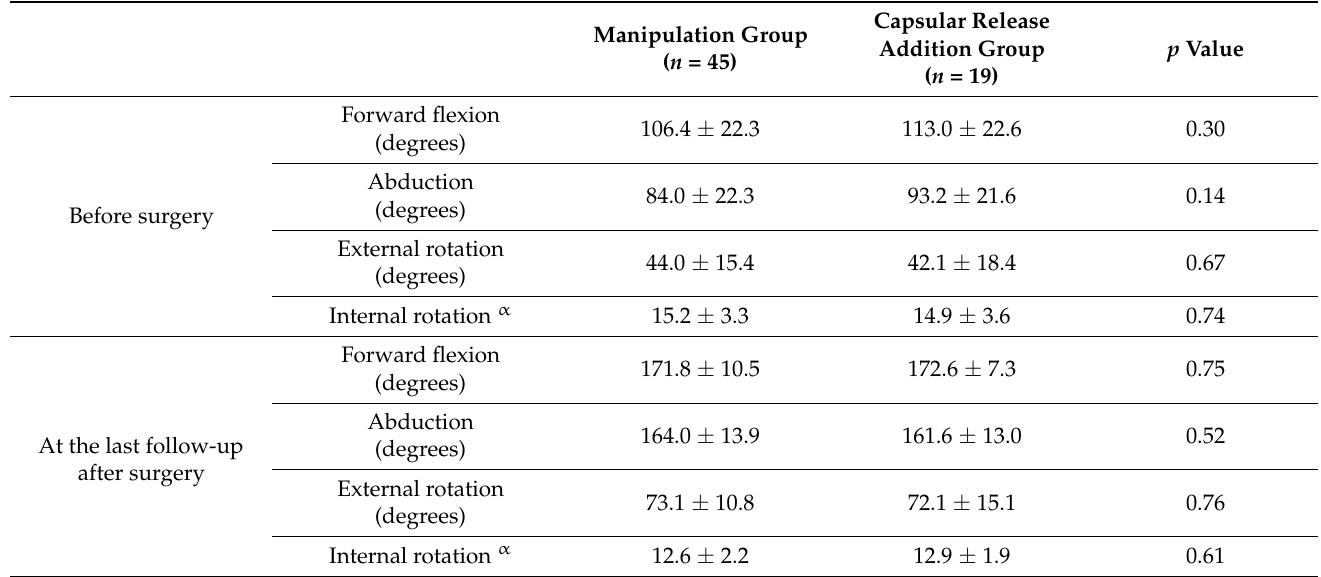
Table 3. Comparison of passive ROM before and after surgery between the two groups. Manipulation Group ( n =